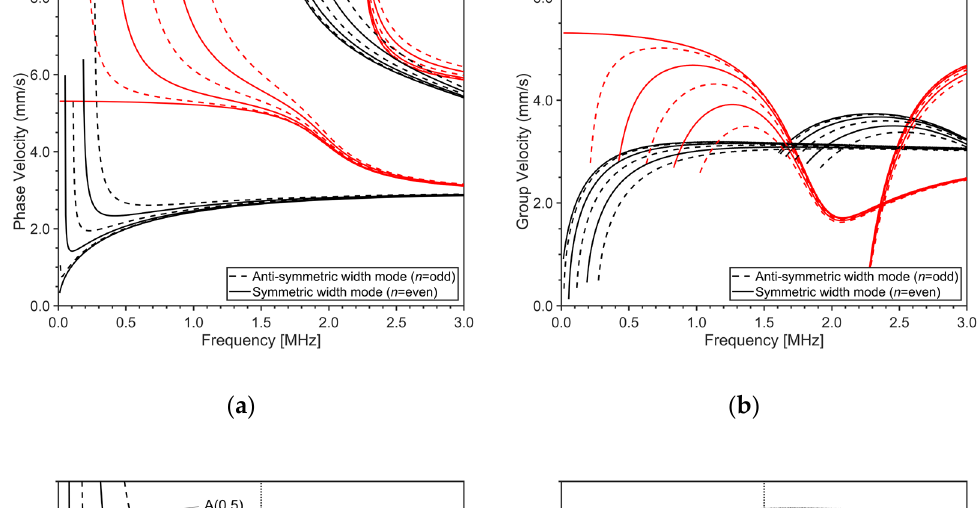
Figure 2. Dispersion curves of Lamb waves in SS304 plate ( ρ = 7800 kg / m 3 , C L = 5800 m / s and C S = 3160 m / s) with thickness of 1.2 mm and width of 15 mm: ( a ) phase velocity dispersion curves, ( b ) group velocity dispersion curves, ( c ) phase velocity dispersion curves of A(0, n ) modes, and ( d ) group velocity dispersion curves of A(0, n ) modes; black line: anti-symmetric thickness mode, red line: symmetric thickness mode.